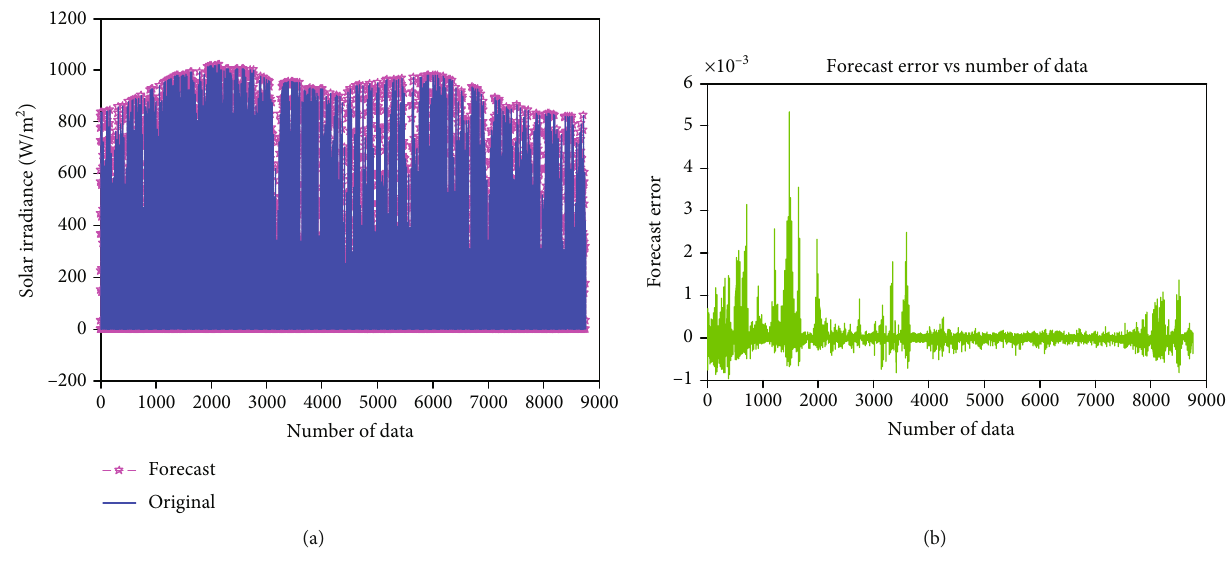
Figure 8: (a) Three input MLPNN-based forecasting model original targets compared to forecast solar irradiance. (b) Three input MLPNN- based forecasting model forecasting errors vs. the number of data